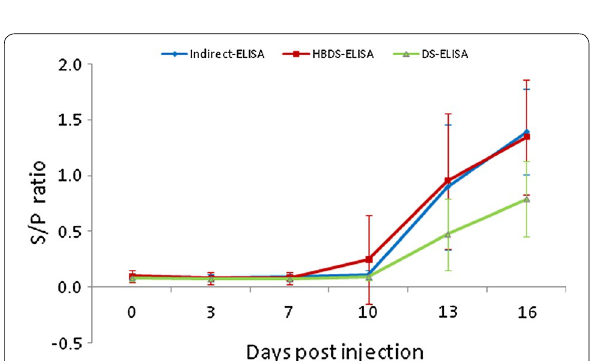
Fig. 5 Mean PCV2 specific serum antibody titers of the nine pigs experimentally infected with PCV2. Standard deviations are indicated by the error bars. The S/P cutoffs of the HBDS‑ELISA, DS‑ELISA and Indirect ELISA were 0.2, 0.27 and 0.35,